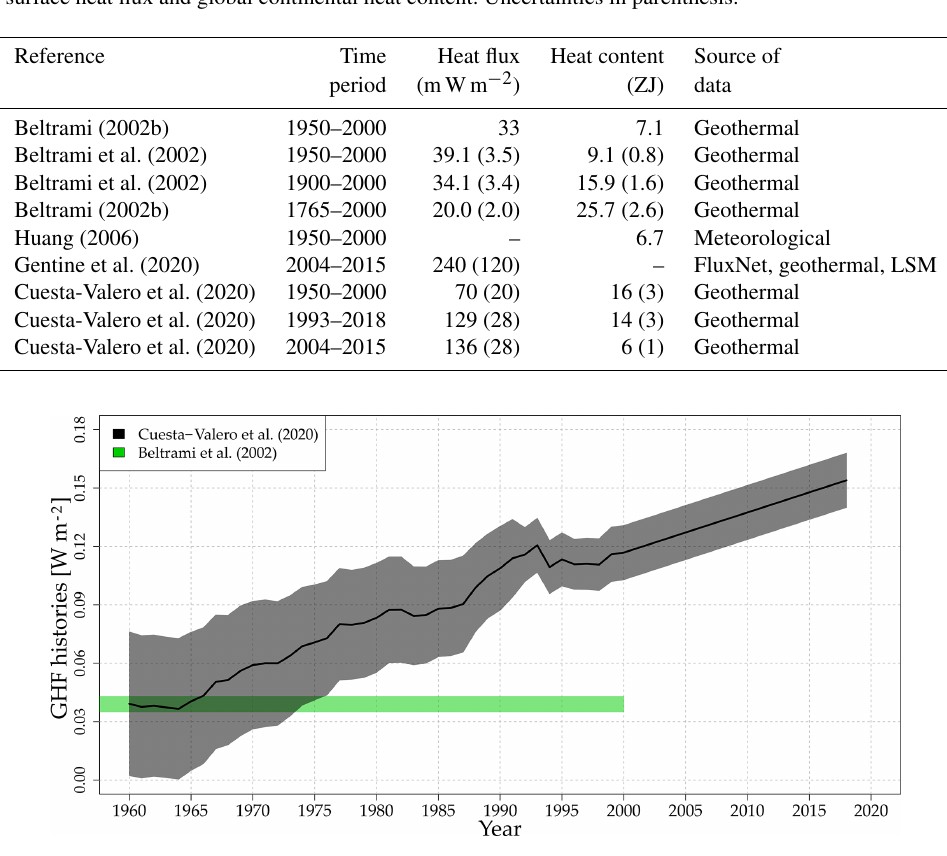
Figure 4. Global mean ground heat flux history (black line) and 95% confidence interval (gray shadow) from BTP measurements from Cuesta-Valero et al. (2020). Results for 1950–2000 from Beltrami et al. (2002) (green bar) are provided for comparison